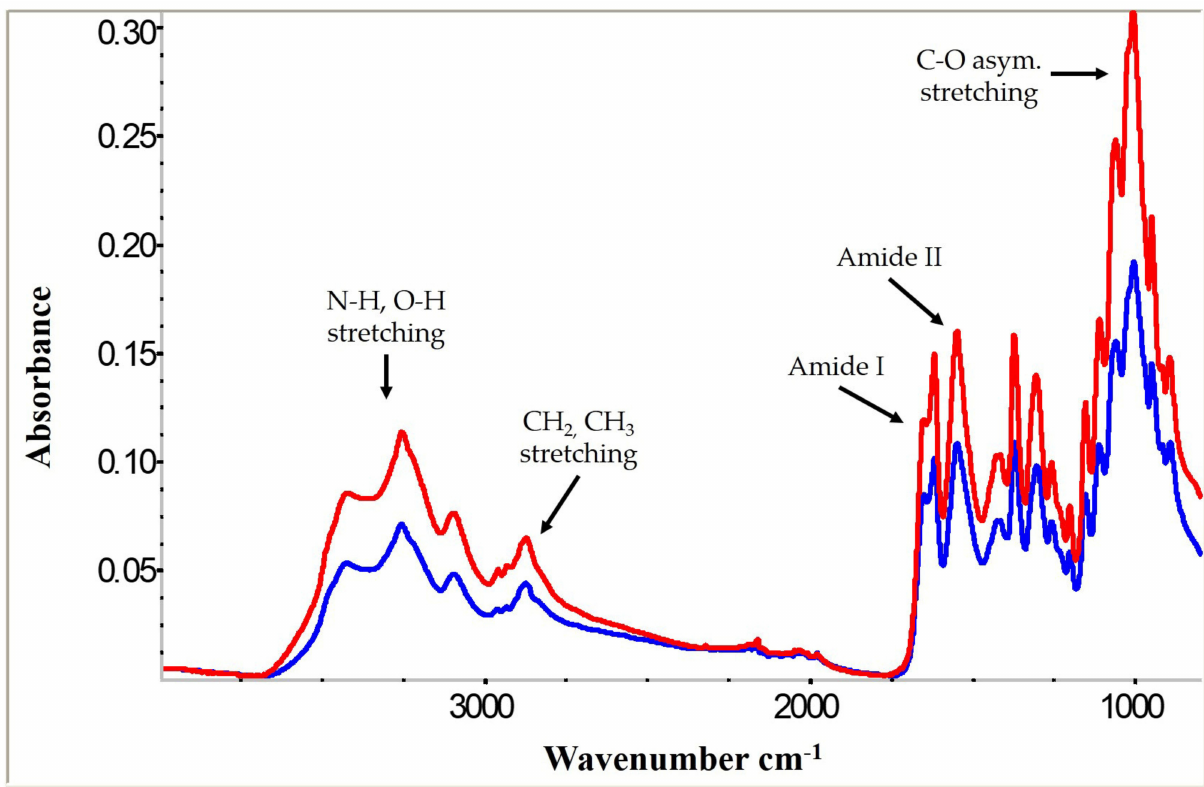
Figure 1. FTIR spectra of A. domesticus ( blue ) and G. sigillatus ( red ) purified chitin. Spectral peaks related to chitosan’s chemistry have been extensively reported. Follow- ing deacetylation of chitin, chitosan samples produced from both cricket species were